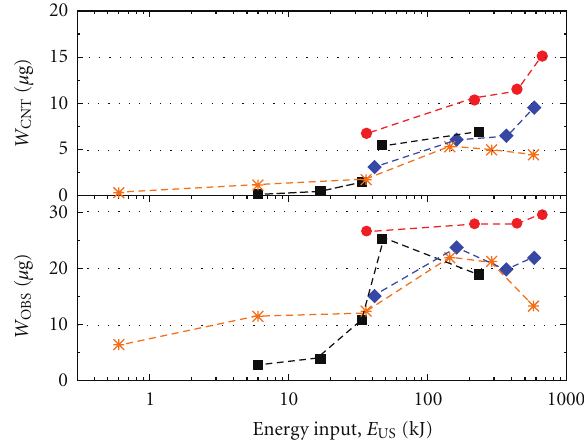
Figure 13: Mass of CNTs in the suspension, W CNT , (upper graph) and the total detected mass between 20nm and 2 μ m, W OBS , (lower graph) at increasing energy input, E US at di ff erent horn amplitudes: 10% ( (cid:2) ), 20% ( (cid:3) ), 40% ( • ), and bath sonicator ( ∗ ).